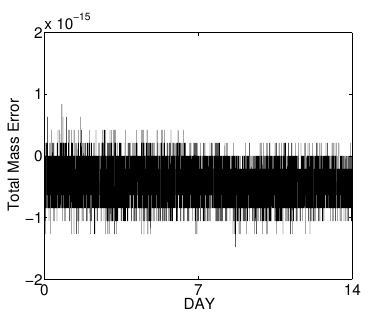
Figure 13. Normalized conservation error of total mass on grid G 12 for case 6.